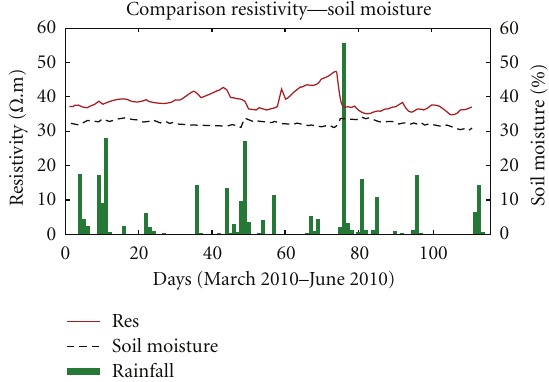
Figure 14: Comparison between Resistivity and TDR data acquired at 1m depth, in correspondence of the 14 electrode.